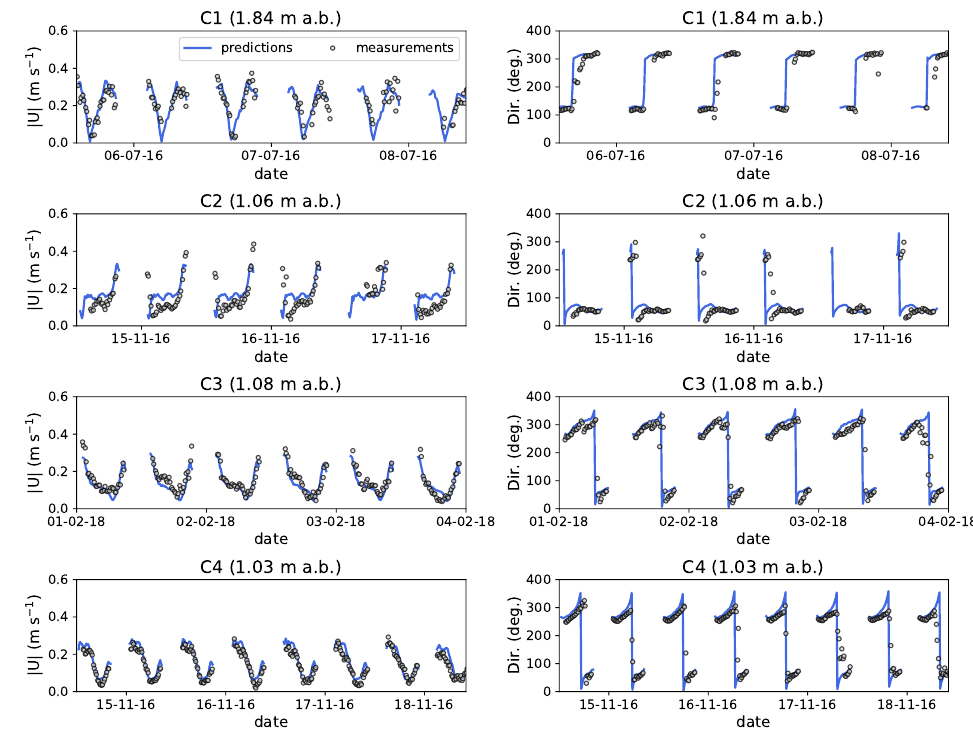
Figure 6. Time series of observed and predicted total water depths with oyster tables (in configuration E 3 ) at points D1 ad D2.